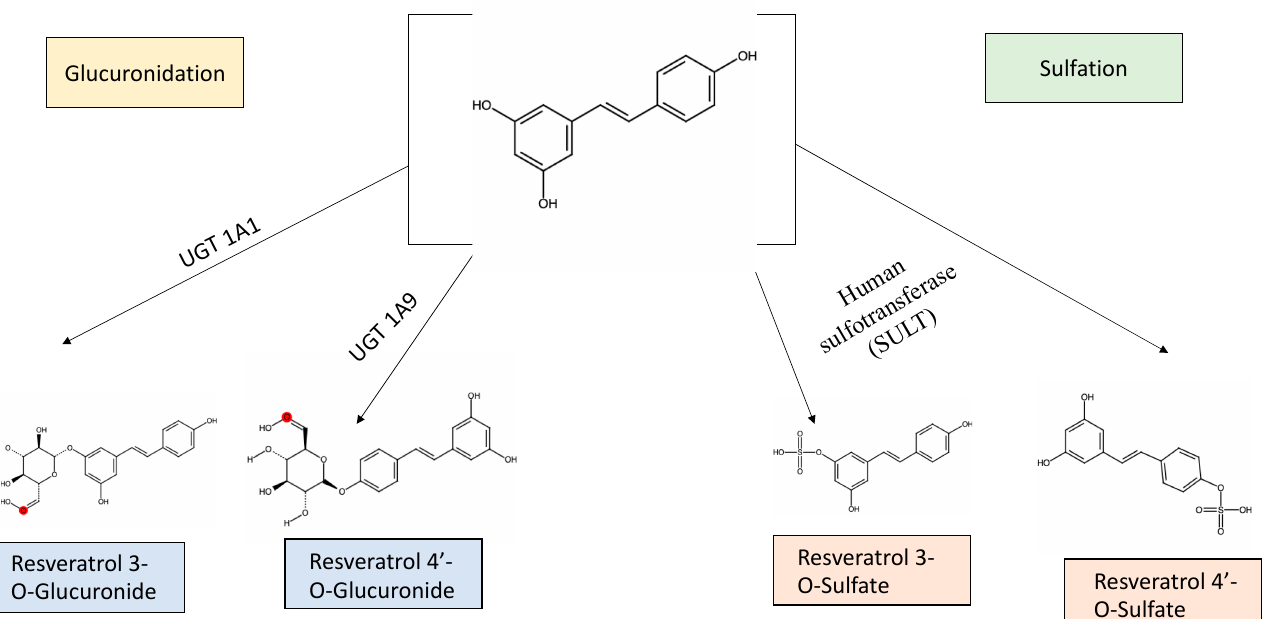
Figure 2. Representation of the metabolism of Resveratrol along with its main